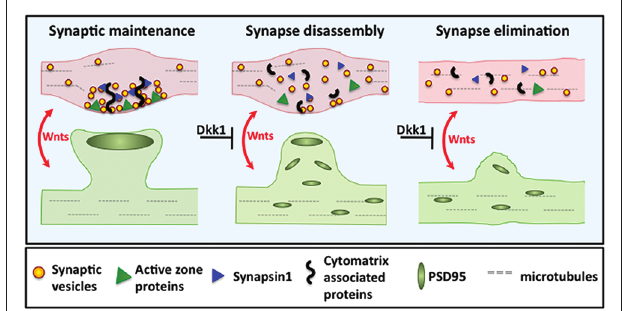
FIGURE 4 | Wnt blockade by Dkk1 induces synapse disassembly . Left panel: Wnt signaling maintains pre- and postsynaptic stability. Middle panel: Blockade of Wnt signaling by Dkk1 induces dispersal of synaptic proteins. During Wnt blockade, functionally diverse synaptic components such as SVs, Synapsin1 and active zone proteins disperse from presynaptic sites. Postsynaptically, PSD95 also disperses. Right panel: Synapse disassembly eventually leads to synapse